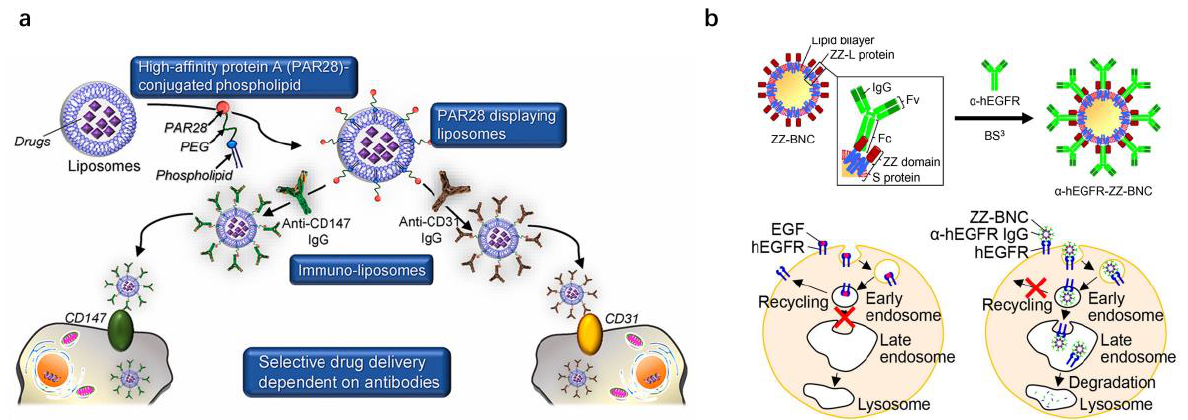
Figure 5. Examples for the construction of active targeting drug delivery carriers based on affinity motif. ( a ) Schematic illustration of the structure of PAR28-PEG-liposomes and construction of immune-liposomes for specific cellular uptake. Reproduced with permission from Ref.